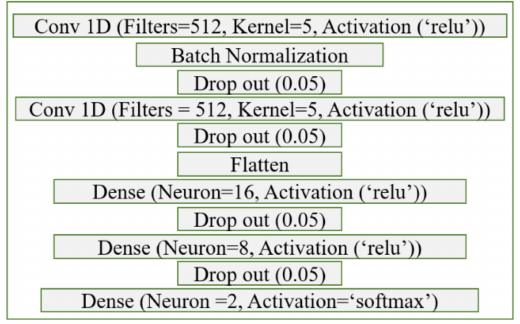
Figure 9. The CNN network parameters are tuned for optimal performance.